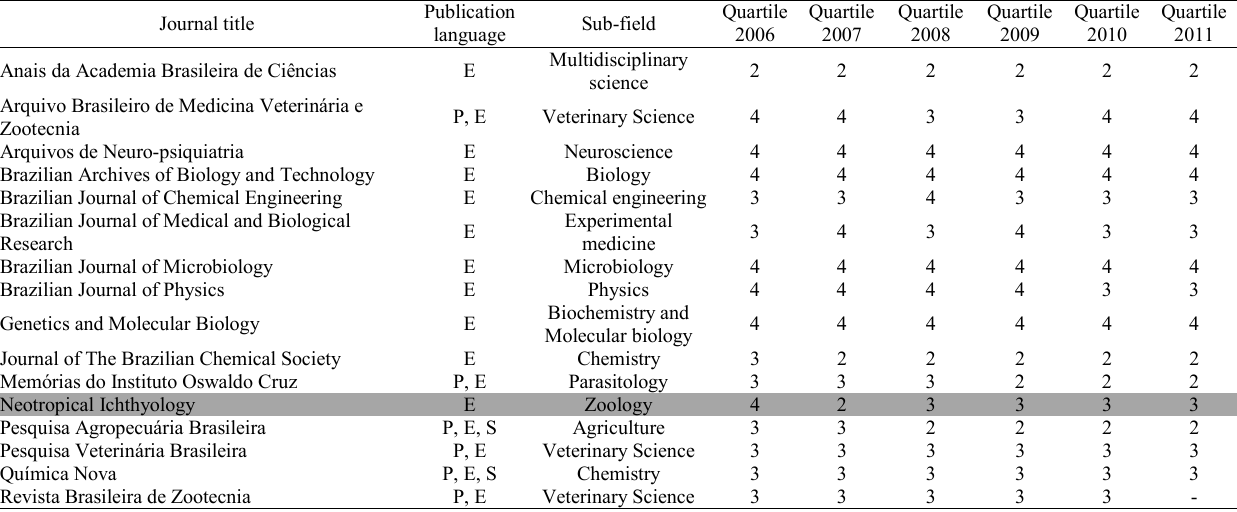
Table 2. Quartile ranking of the IF of Brazilian journals in their corresponding fields and publication language.